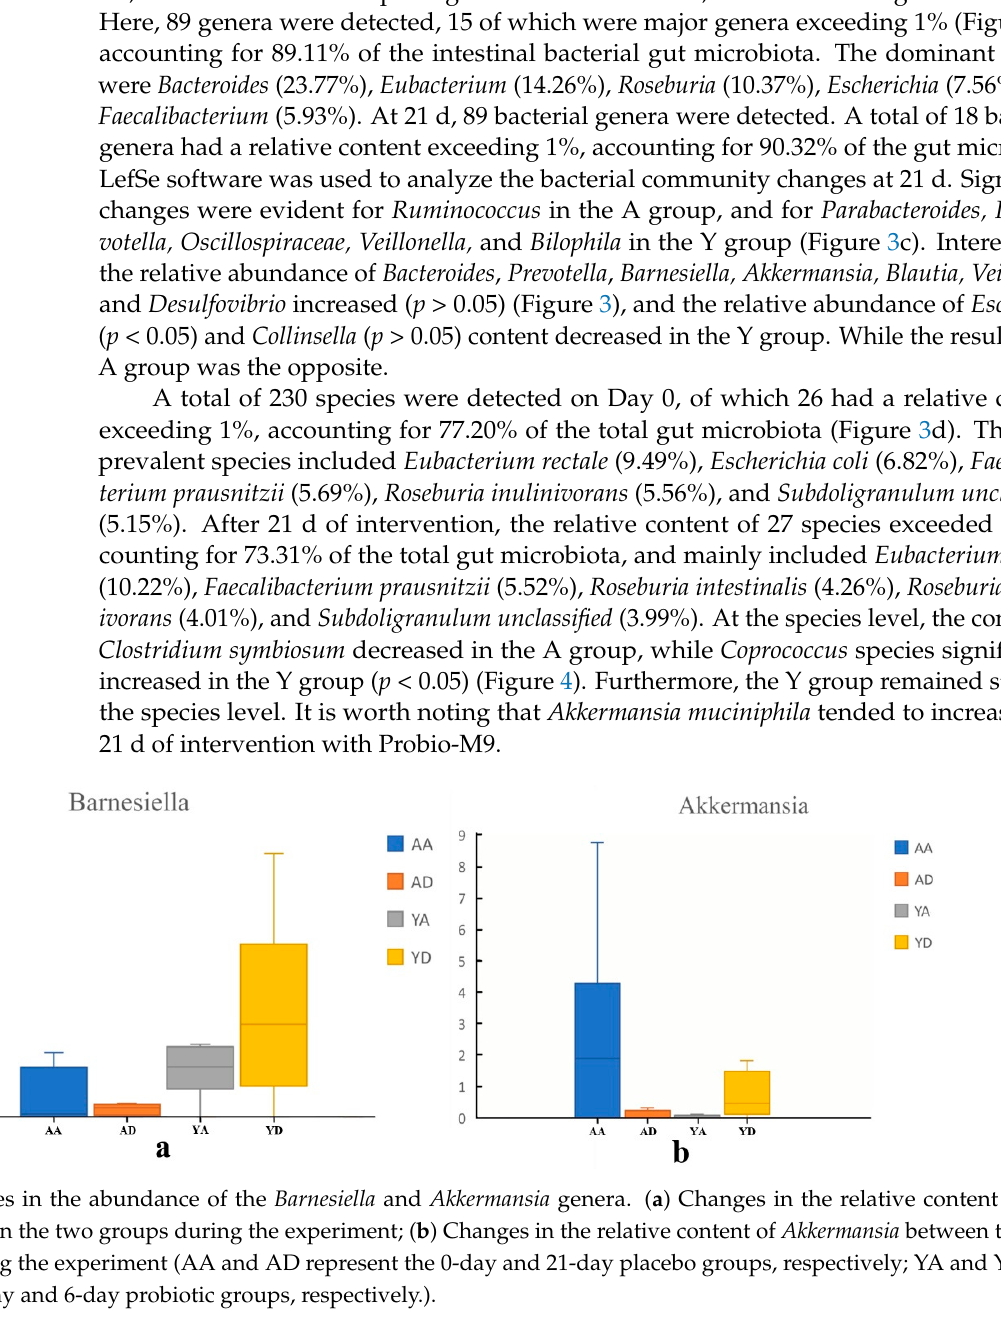
Figure 4. Changes in the abundance of the Barnesiella and Akkermansia genera. ( a ) Changes in the relative content of Barnesiella between the two groups during the experiment; ( b ) Changes in the relative content of Akkermansia between the two groups during the experiment (AA and AD represent the 0-day and 21-day placebo groups, respectively; YA and YD represent the 0-day and 6-day probiotic groups, respectively.).